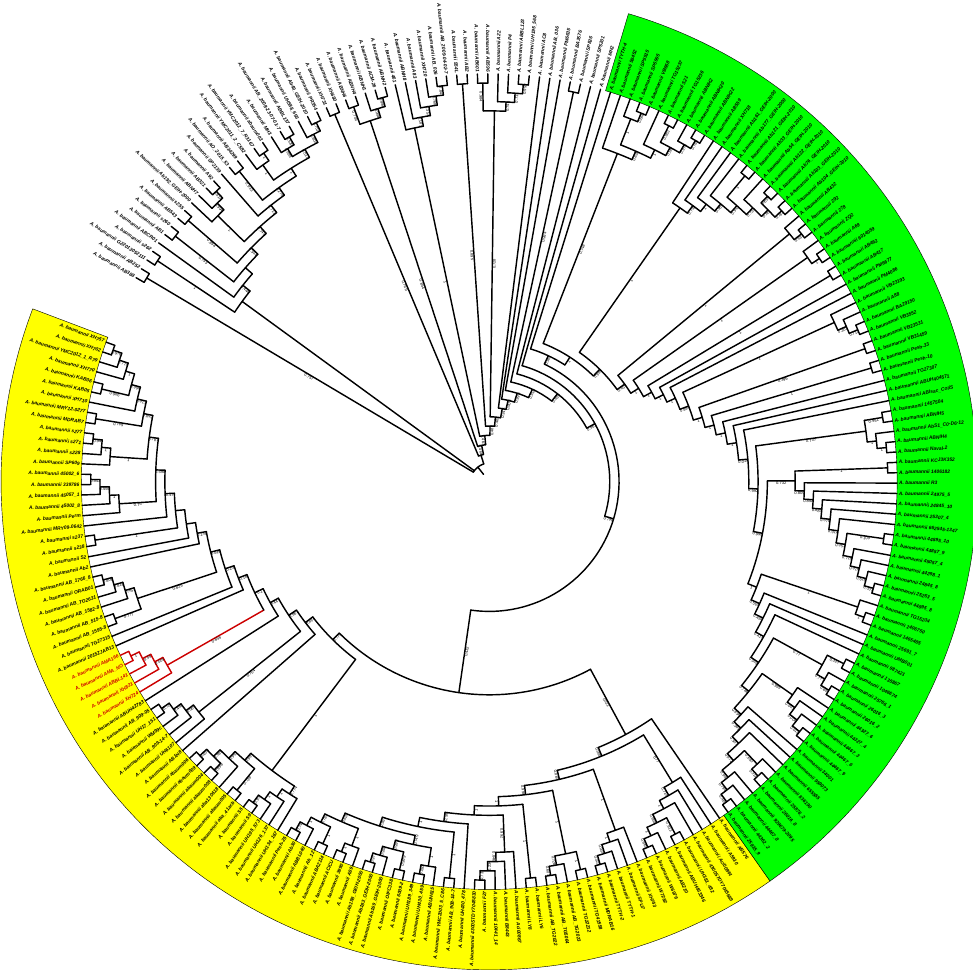
Figure 1. Core-genome phylogenetic analysis of AMA_NO, AMA166, and 239 representative genomes of ST2 A. baumannii clone. The figure displays the maximum likelihood phylogeny of 241 A. baumannii sequences. The bootstrap method was used as a supporting method (1000 iterations). The molecular substitution model was GTR. The tree representation was done by iTOL. Phylogenetic genomes related with AMA_NO and AMA166 is represented with the red branch. Yellow and green highlights represent A and B phylogenetic cluster, respectively. High resolution figures